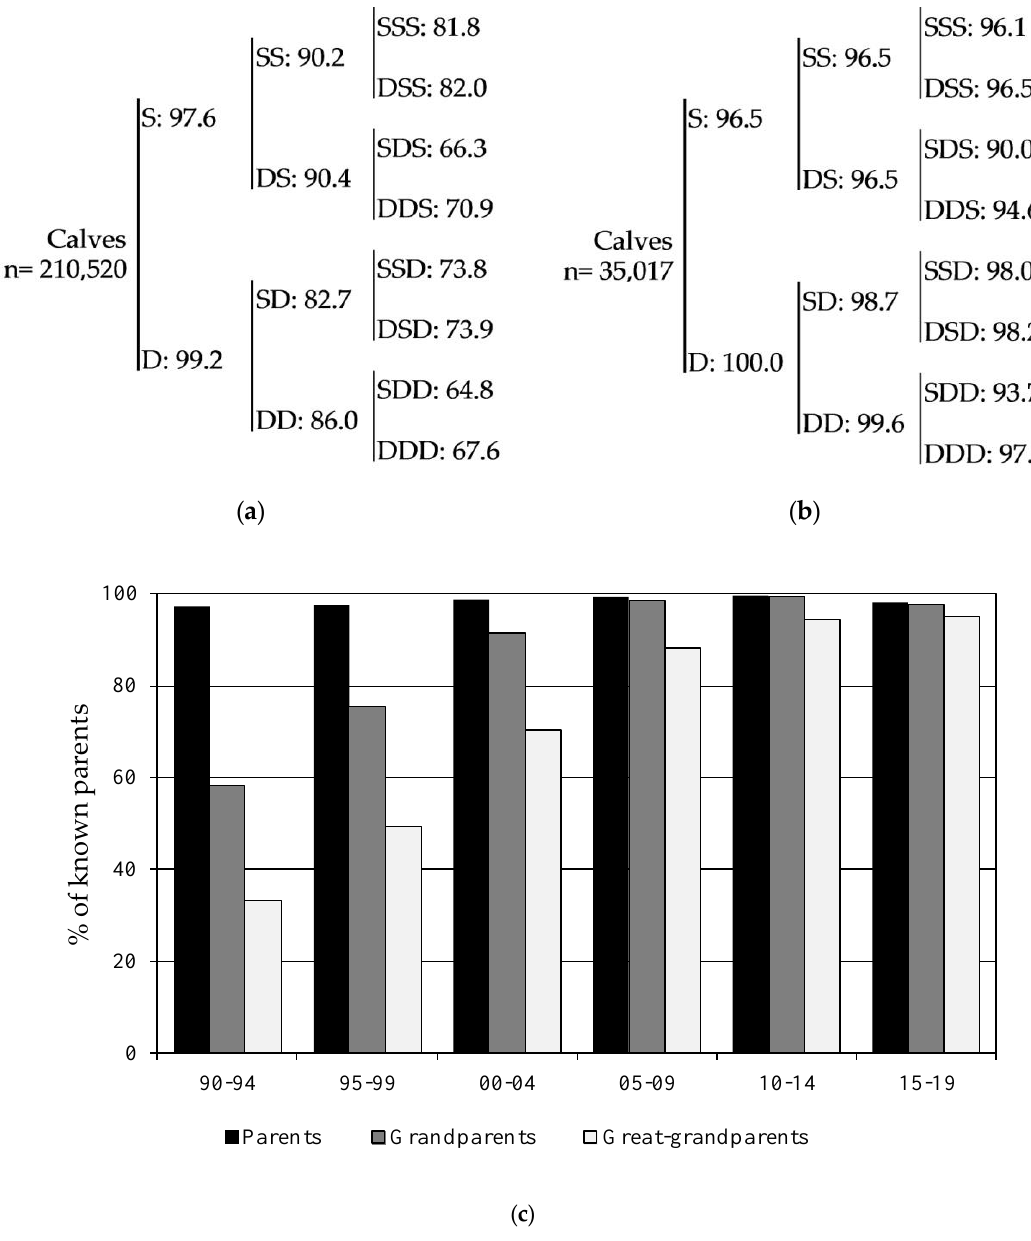
Figure 6. Average percentage of sires (S), dams (D), paternal and maternal grandparents (SS, DS, SD, and DD), and great-grandparents (SSS, DSS, SDS, DDS, SSD, DSD, SDD, and DDD) known for: ( a ) The whole population, ( b ) calves born between 2015 and 2019 and ( c ) average percentage of ancestors known by periods of 5 years.